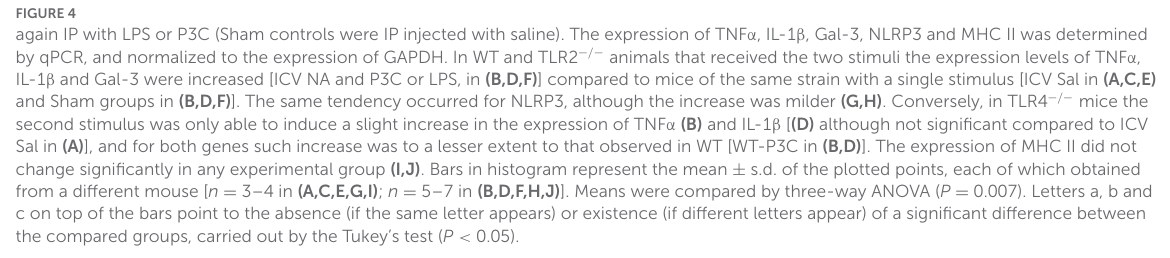
NA administration (Fernandez-Arjona et al., 2019a).